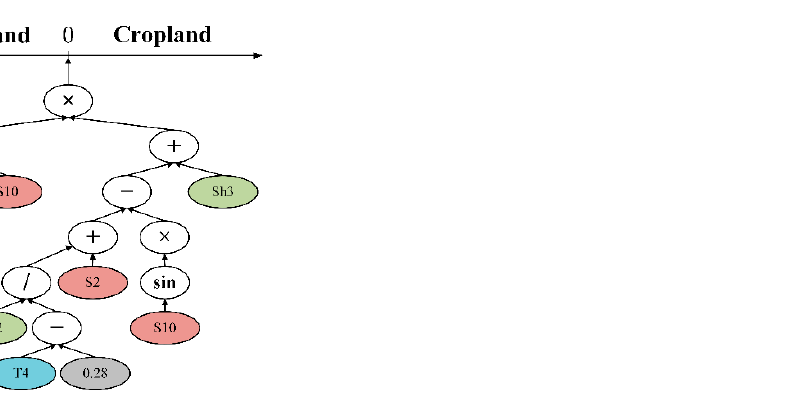
Figure 2. The GP individual represents a classifier. The colored leaf nodes represent terminals, while the white internal nodes represent functions.